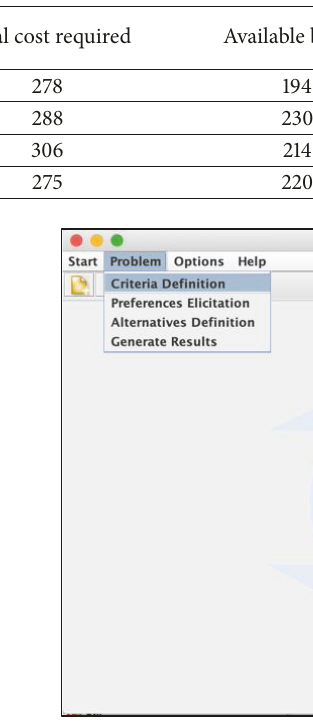
Table 6: Level of efficiency in resource use for VDA and SBSE methods.